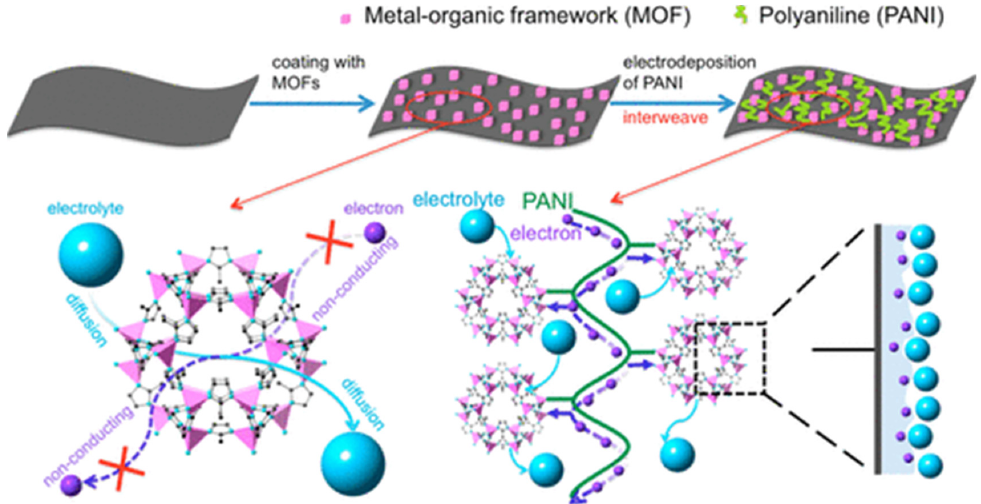
Figure 21. Preparation process for the polyaniline (PANI)–cobalt-based MOF crystals (ZIF-67)–carbon cloth (CC) for SCs applications and its conduction mechanism [100]. Reproduced with permission. The SC performance of the prepared (PANI)-cobalt-based MOF crystals (ZIF-67)–carbon cloth (CC) electrode is as shown in Figure 22.